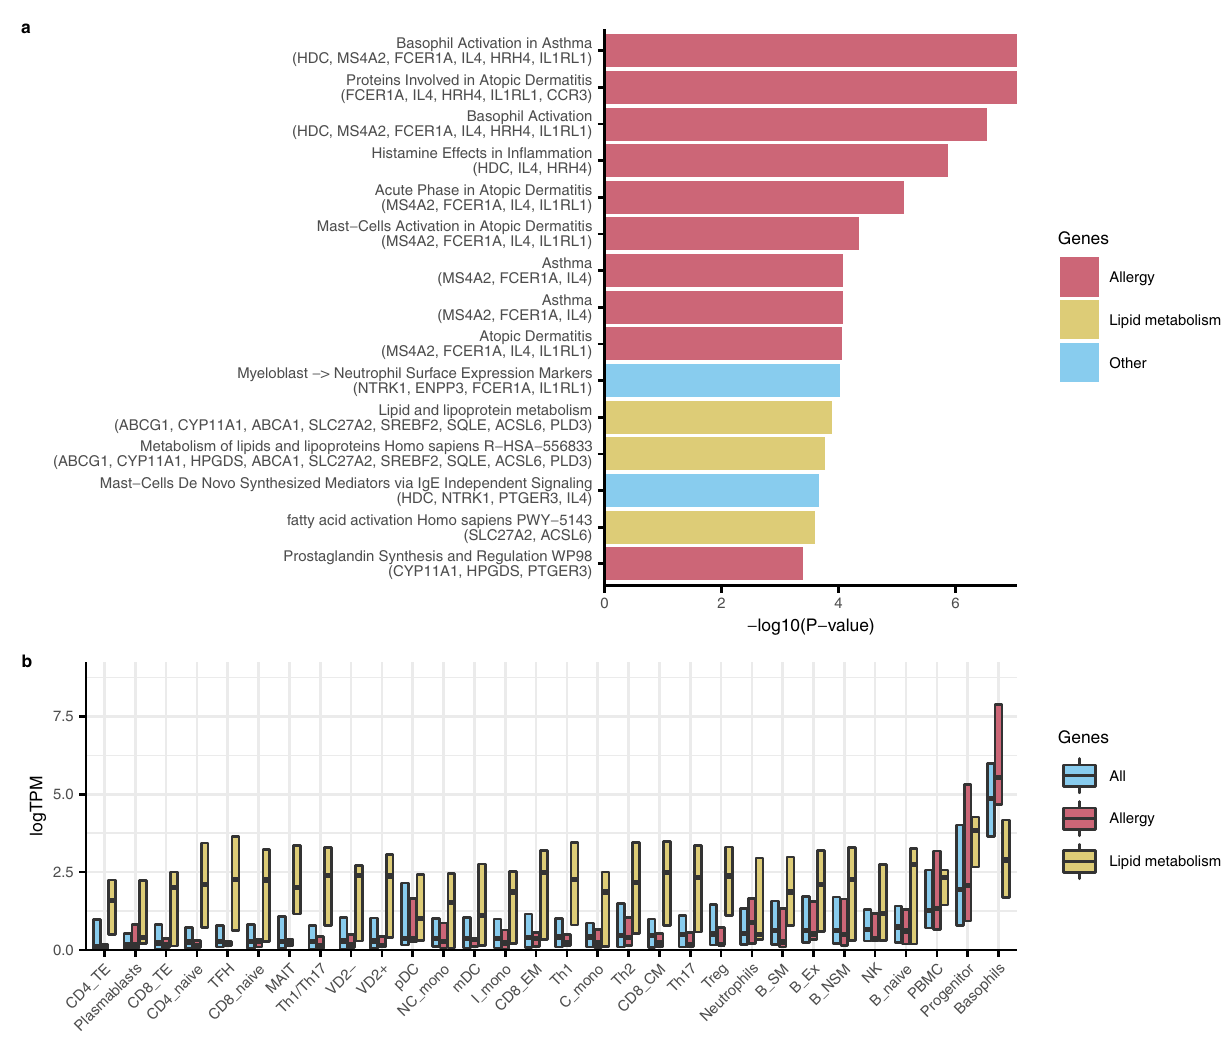
Fig. 3 | TG-affected genes are enriched for lipid metabolism and allergy path- ways and show cell-speci fi c expression patterns in line with gene function. a Pathway enrichments generated using a one-sided Fisher ’ s exact test with clusterPro fi ler 56 using the 10 human pathway databases BioPlanet 2019, WikiPath- ways 2019 Human, KEGG 2019 Human, Elsevier PathwayCollection, BioCarta 2015, Reactome 2016, HumanCyc 2016, NCI-Nature 2016, Panther 2016, and MSigDB Hallmark 2020. The top 15 enrichments are shown. b Lipid metabolism genes are expressed in all blood cell types, but genes involved in allergy are expressed especially in basophils. Depicted are medians and interquartile range. Based on publicRNA-seqdata 24